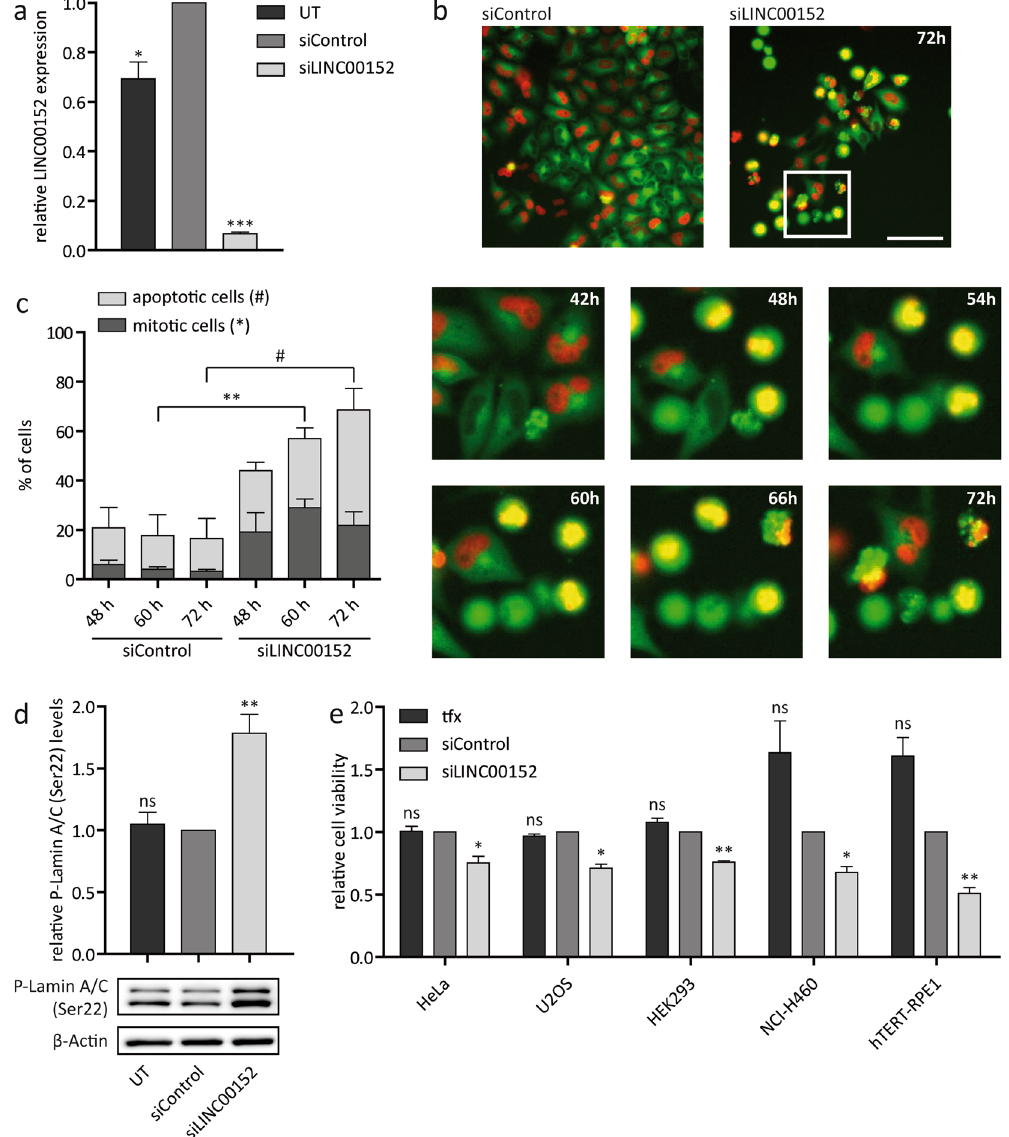
Figure 4. Live-cell microscopy revealed a cell division phenotype with high temporal resolution. ( a ) Relative expression of LINC00152 detected by RT-qPCR and normalized to Cyclophilin A expression in untreated HeLa cells and cells transfected with 30 nM siPOOLs. ( b ) Endpoint images (upper panel) and magnified time-lapse microscopy pictures (lower panel) of HeLa cells treated with 30 nM siPOOLs. Images were acquired at 20x magnification and scale bar represents 200 μ m. Live-cell imaging revealed a mitotic arrest in prometaphase and reduced cell viability after LINC00152 depletion. Time depicts hours after transfection. ( c ) Quantification of mitotic (significance * ) and apoptotic (significance # ) cells at three different time points after RNAi knockdown. ( d ) Validation of mitotic arrest by quantification of P-Lamin A/C (Ser22) levels detected by Western blot and normalized to β -Actin levels in HeLa cells. ( e ) Relative cell viability detected by CellTiter-Glo Luminescent Cell Viability Assay in different cell lines treated with siPOOLs. UT = untreated; tfx = transfection reagent only. N = 3. Error bars indicate SEM. * /# p < 0.05; ** p < 0.01; *** p < 0.001; ns = not